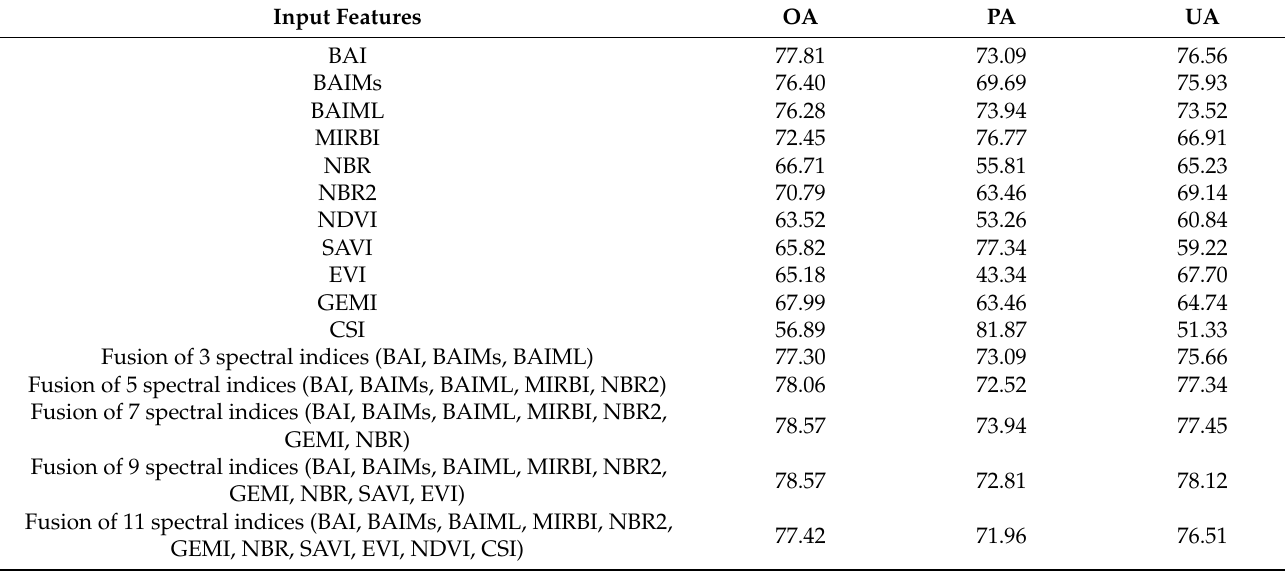
Figure 5. Demonstration of harmonic model fit before and after burned area detection for a single pixel, based on different spectral indices with burned pixels having lower values than unburned pixels. The black points are unburned pixels, the red points are burned pixels, the green points are commission pixels, the blue curve is the harmonic model, and the dashed blue line is the threshold for detecting burned pixels. Table 3. Accuracy assessment for different